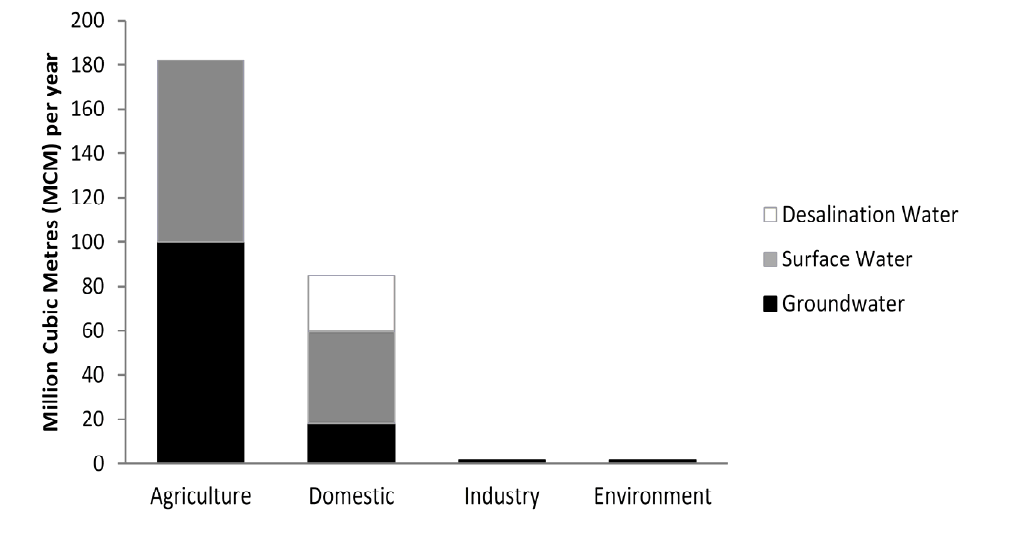
Figure 5. Water Demand by sector and sources used for the year 2006 (Data: WDD statistics